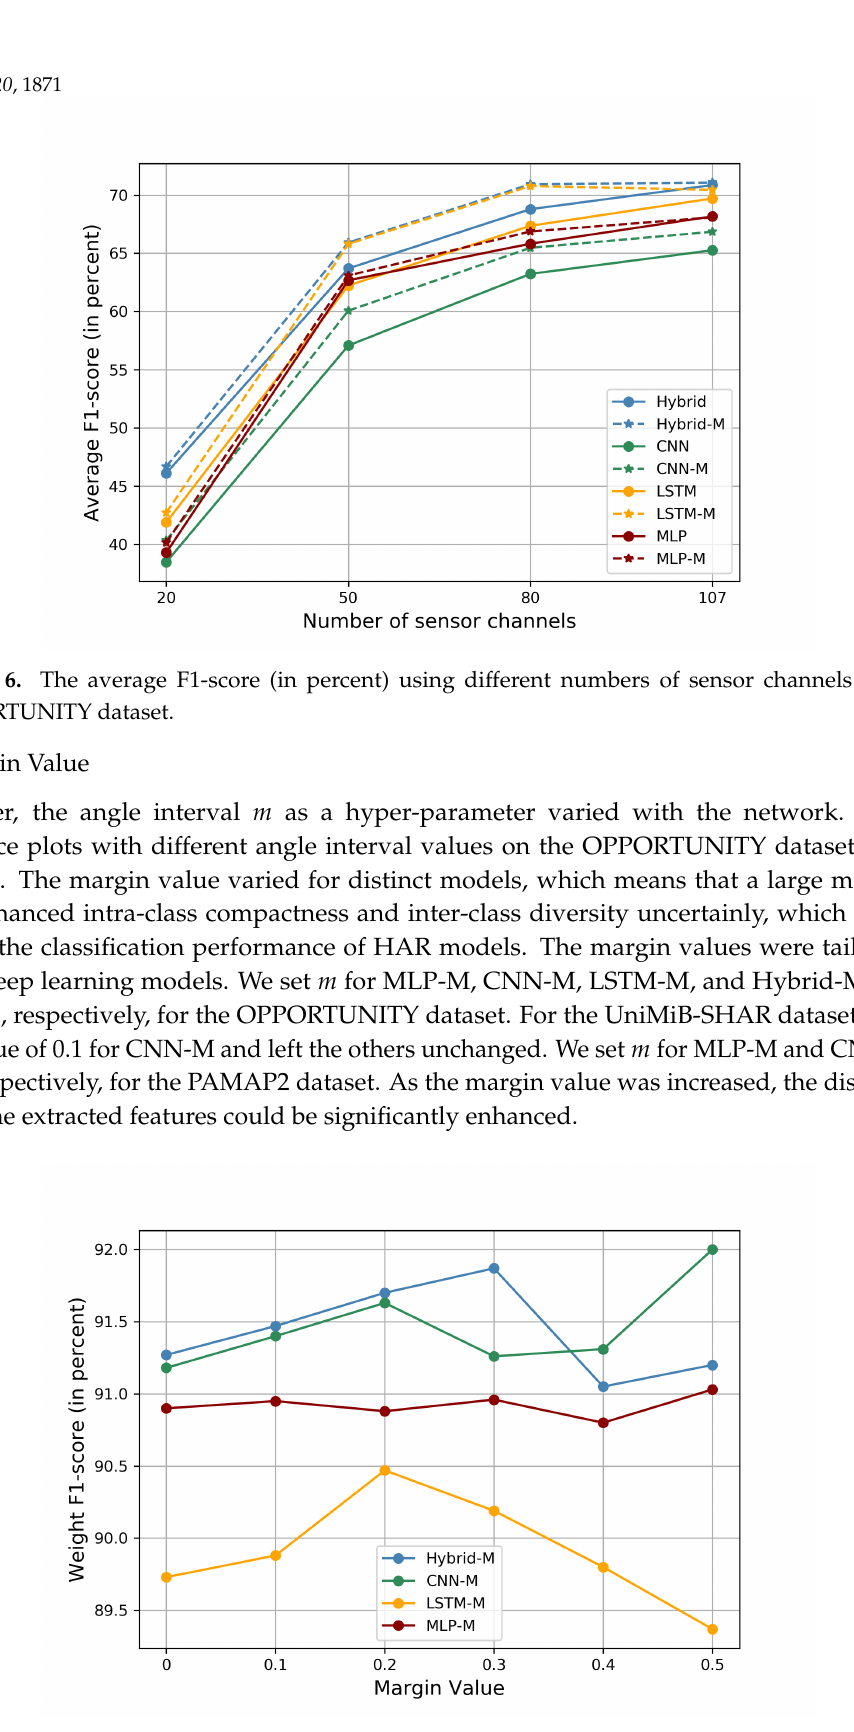
Figure 7. The weighted F1-score (in percent) of the margin-based models for different margin values with the OPPORTUNITY